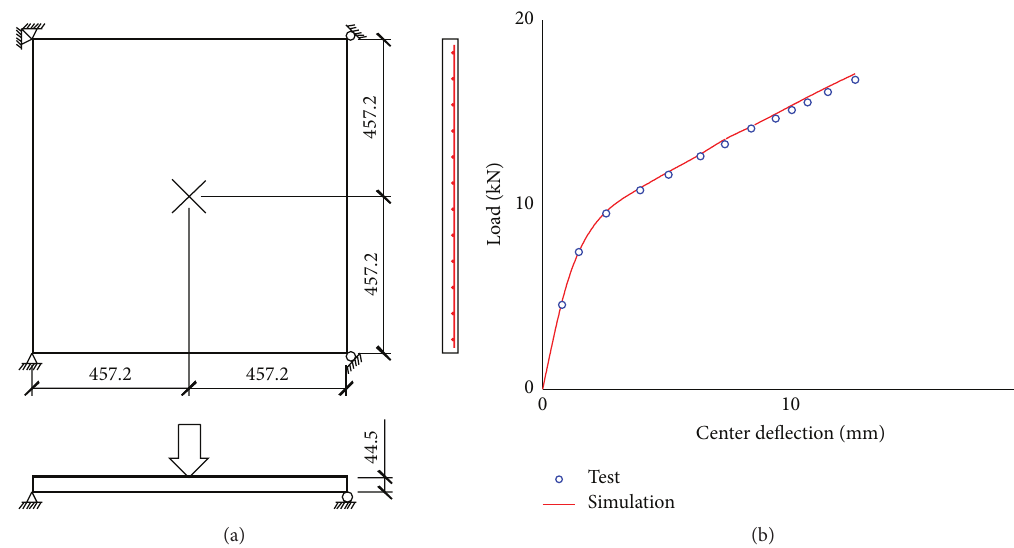
Figure 1: Reinforced concrete slab under out-of-plane loading [16]. (a) Setup (dimensions in mm). (b)